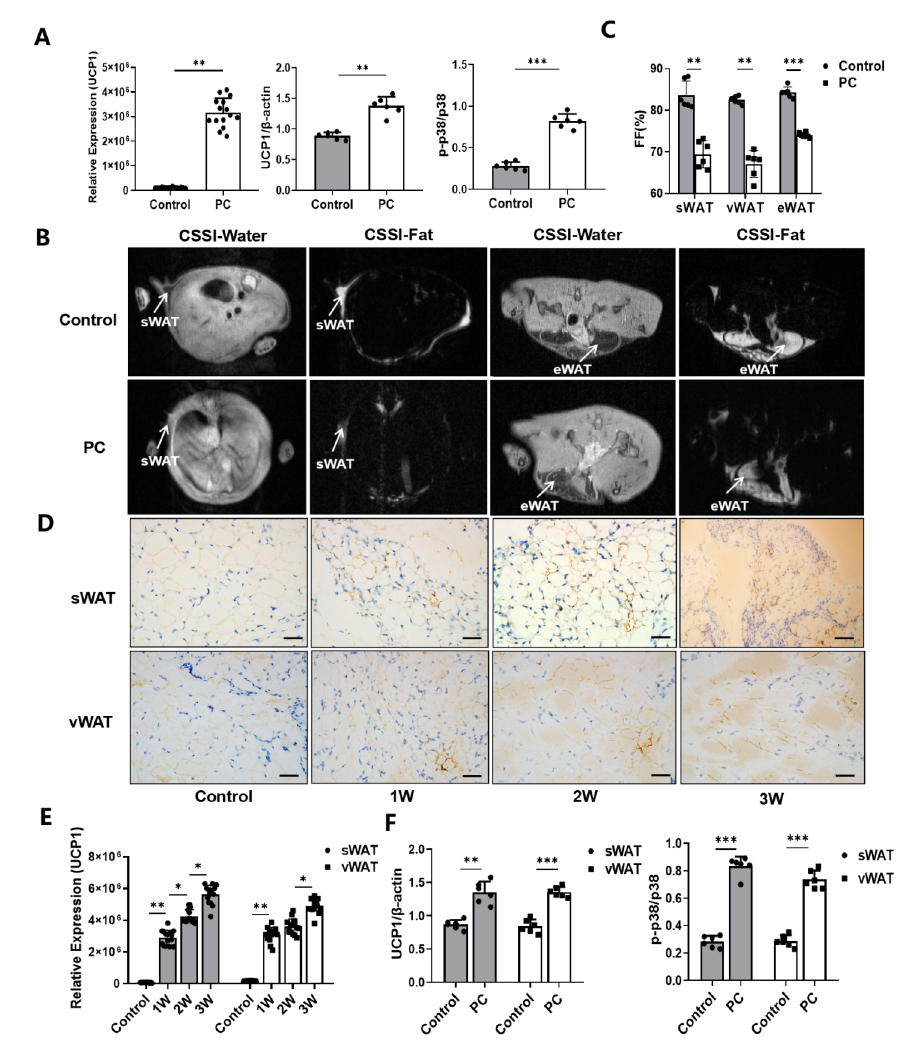
Figure 2. Browning of WAT and associated CAC. ( A ) The expression levels of UCP1, p-p38 and p38 protein of white adipocytes cultured with or without the Panc02 cancer cell-conditioned medium. ( B ) CSSI MRI of healthy control mice and mice with pancreatic cancer. ( C ) Measurement of the FF% of sWAT, vWAT, eWAT and tWAT. ( D ) Immunohistochemical staining of UCP1 protein in sWAT